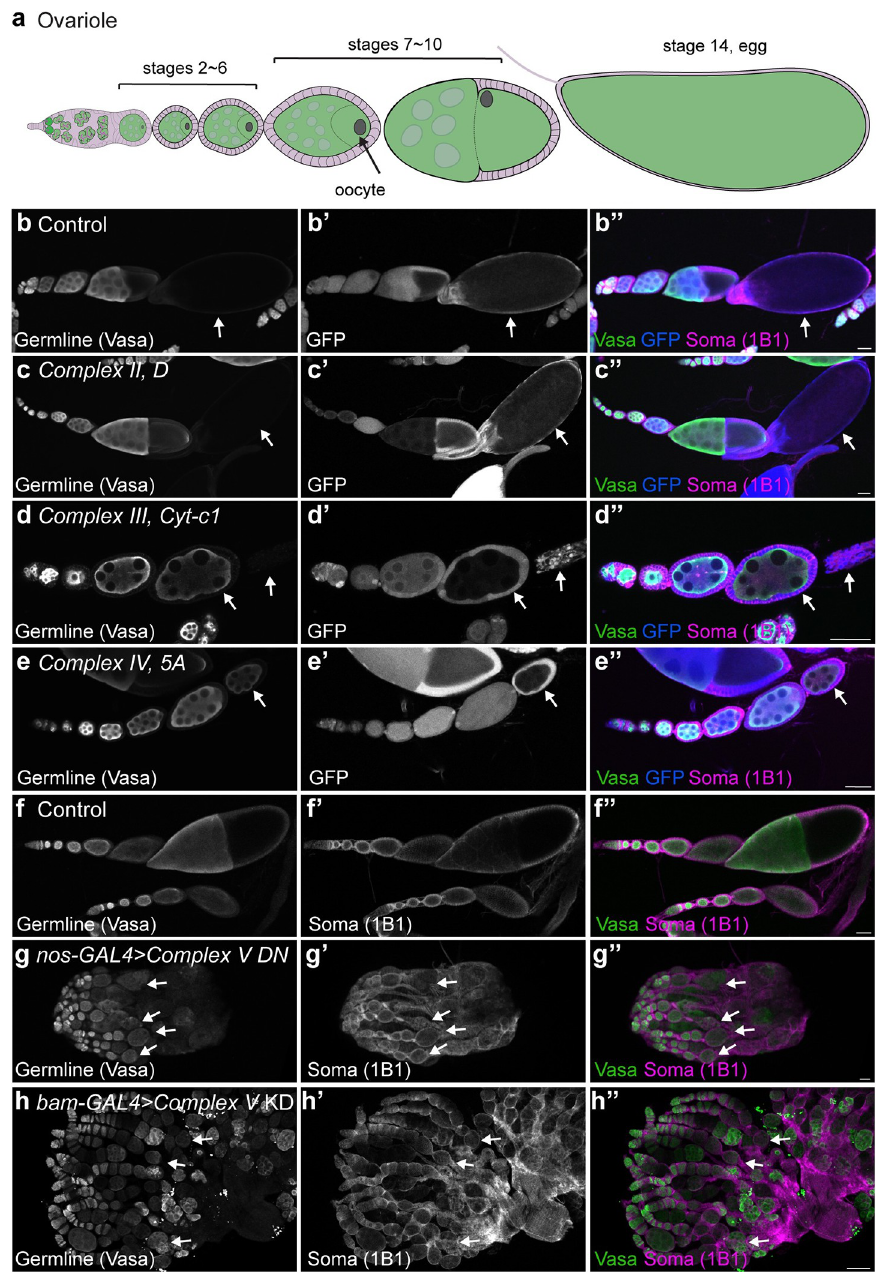
Fig 2. Egg development requires mitochondrial oxidative phosphorylation. (a) Schematic of an ovariole. An egg chamber is comprised of one oocyte, fifteen nurse cells and surrounding somatic follicle cells. Oogenesis comprises 14 stages resulting in the formation of a mature egg. (b-e) Representative images of Control (b) , Complex II subunit D (c) , Complex III Cyt-c1 (d) and Complex IV subunit 5A (e) mosaic ovarioles 14-days post-clone induction. Arrows indicate GFP-negative mutant cells. (f, g) Representative images of 2–3 day old Control (f) and germline expressed ( nos-GAL4 ) Complex V dominant negative (DN) (g) in heterozygous CVc deficiency ovaries. (h) Representative image of a 2–3 day old bam-GAL4 driven CV α RNAi ovary. Arrows indicate the last stage observed in the representative ovariole. For all images scale bars represent 100 μ m. For exact genotypes see S2